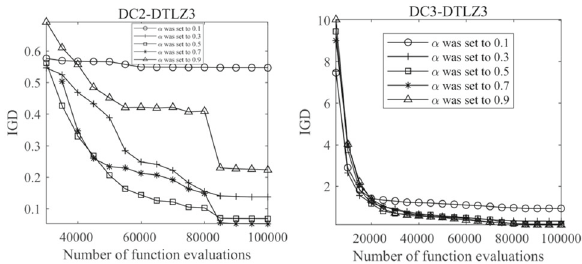
Fig. 10 Convergence profiles of IGD values obtained by the proposed EGDCMO on DC2-DTLZ3 and DC3-DTLZ3 corresponding to differ- ent values of α , averaged over 30 runs